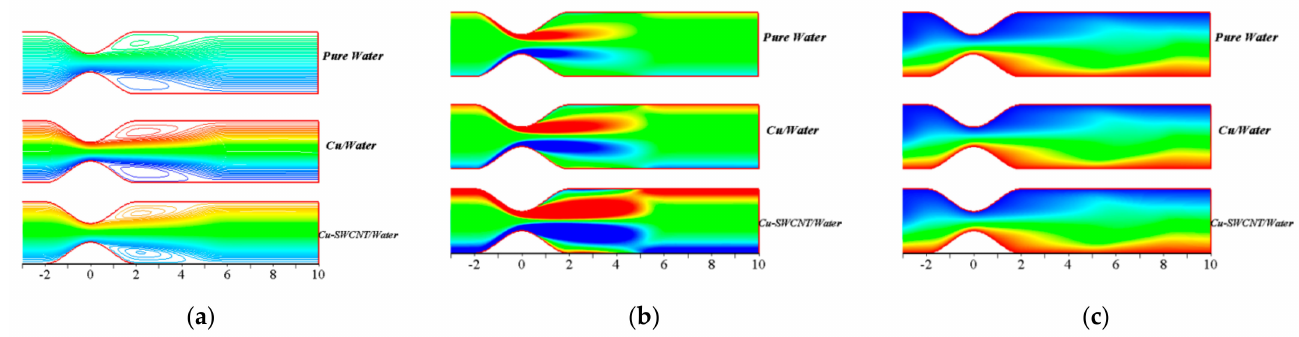
Figure 20. Comparison of pure water, Cu /water, and Cu – SWCNT /water for ( a ) Streamlines, ( b ) vorticity, and ( c ) tempera- ture distributions with Re = 700, M = 5, St = 0.02, Pr = 1, and Rd = 0.2, at the maximum flow rate ( t = 0.25